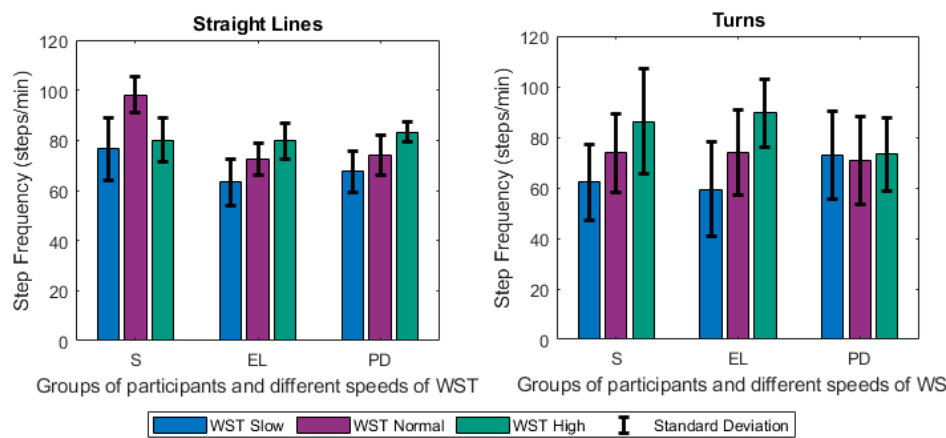
Figure 9. Changes of the Step Frequency (steps/min) for Straight Lines and Turns (mean values along with standard deviation) between the different groups of participants (S, EL, PD) and the different speeds of the WST test (slow, normal, high).